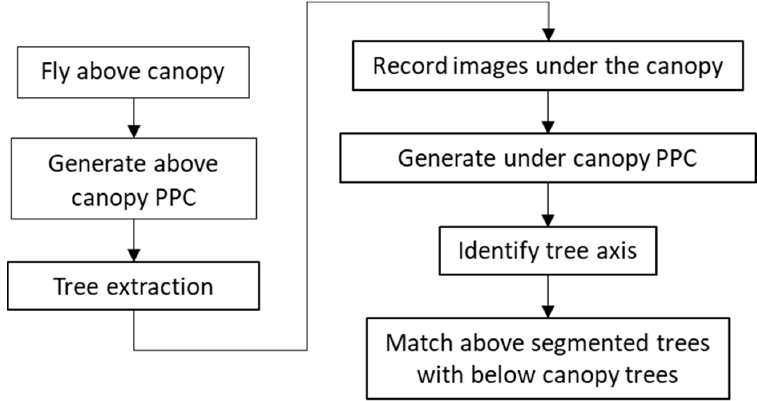
Figure 1. The procedure for geo-referencing trees from no to low accuracy georeferenced images acquired below canopy.